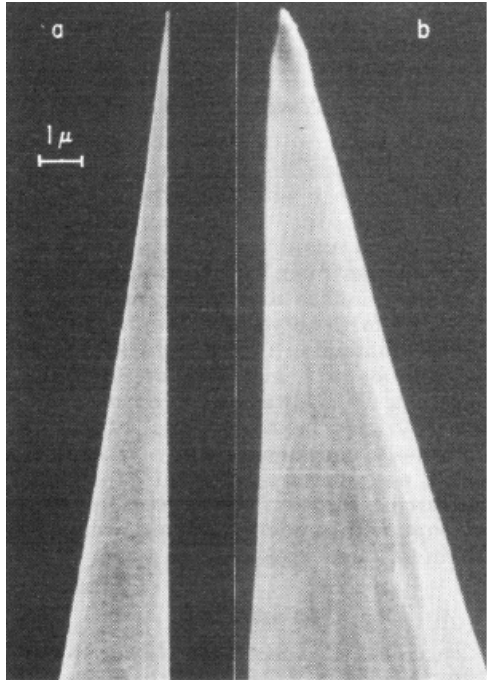
Figure 1. Scanning electron micrographs of microelectrodes made with: (a) DC electropolishing technique and (b) Standard AC electroetching. Reprinted from [39] ©